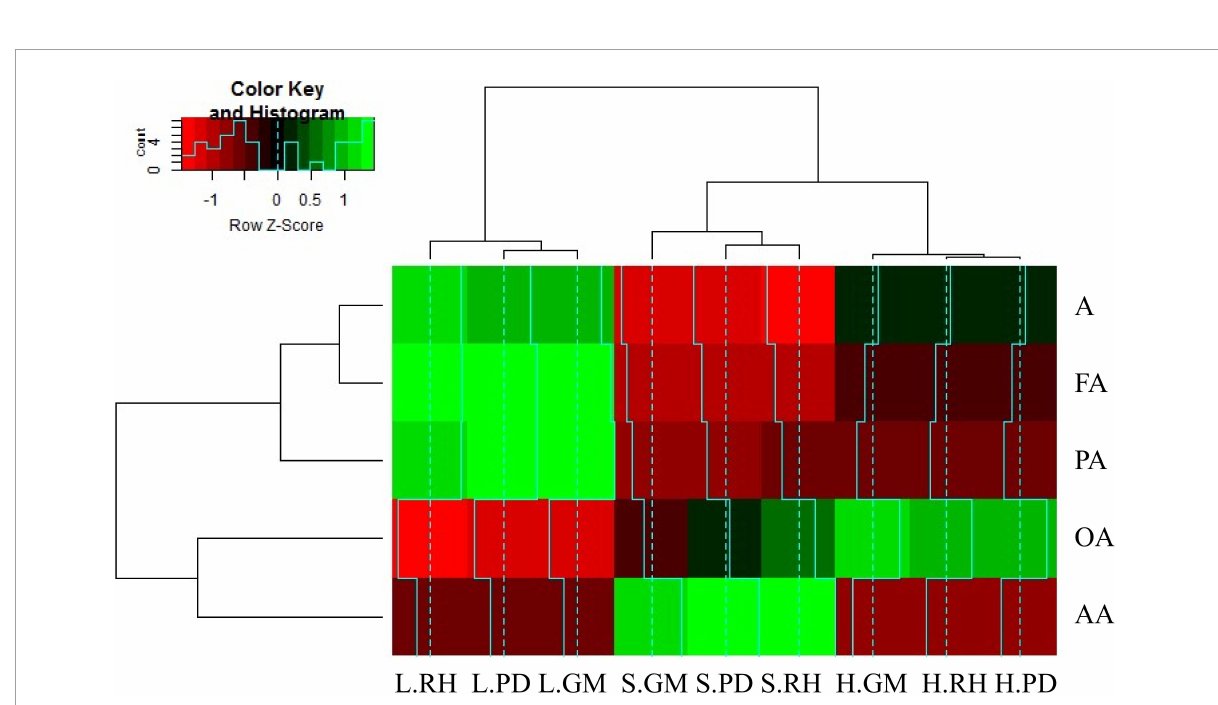
FIGURE4 Hierarchical cluster analysis heatmap between chemical components and soil layers. A, HFA, PA, OA, and AA denote alcohols, higher fatty acids, phenolic acids, organic acids, and amino acids, respectively; L, H, and S indicate litter layer, humus layer, and soil layer, respectively; Renhe (RH), Pudi (PD), and Gamu (GM) denote the three